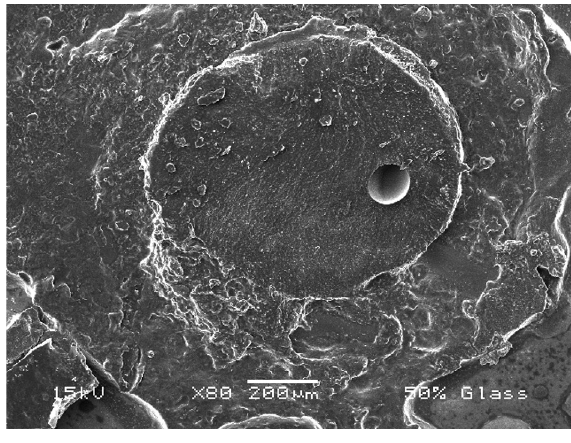
Figure 3. COH mode with an air bubble within the cement bulk.